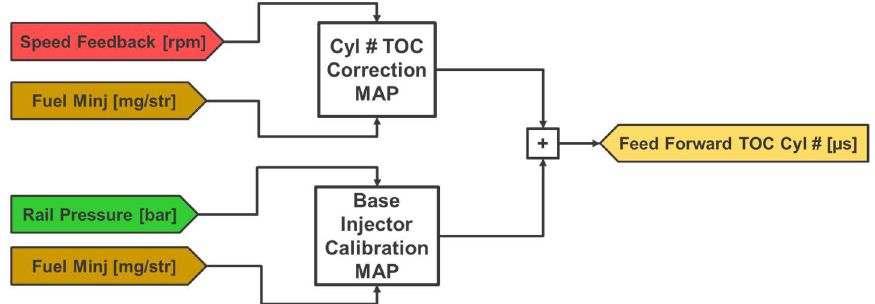
Figure 3. Schematic of the feed-forward model used for the definition of TOC. The feed-forward TOC ( TOC (cid:2890)(cid:2890) [𝜇𝑠]) is defined using two lookup tables (LUTs).